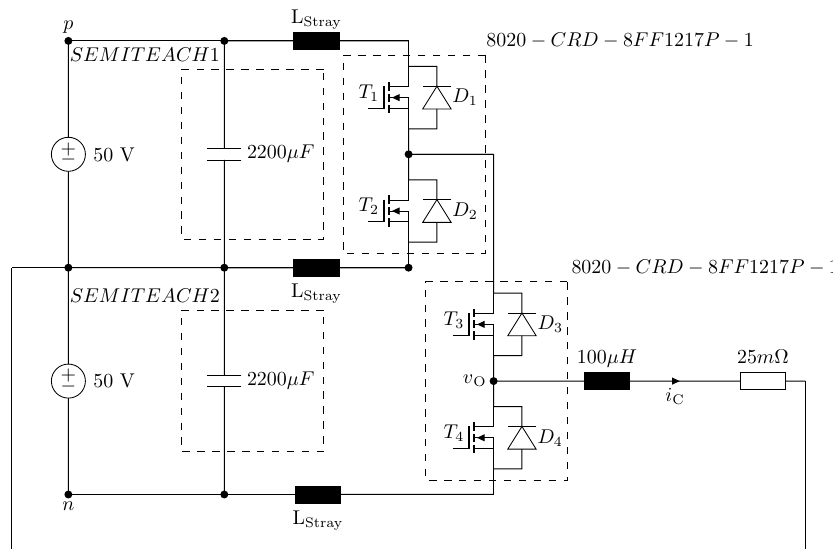
Figure 20. Schematic of the power circuit used during the experiment. One leg of the 3L-ASYM is built by cascading two 8020-CRD-8FF1217P-1 boards.